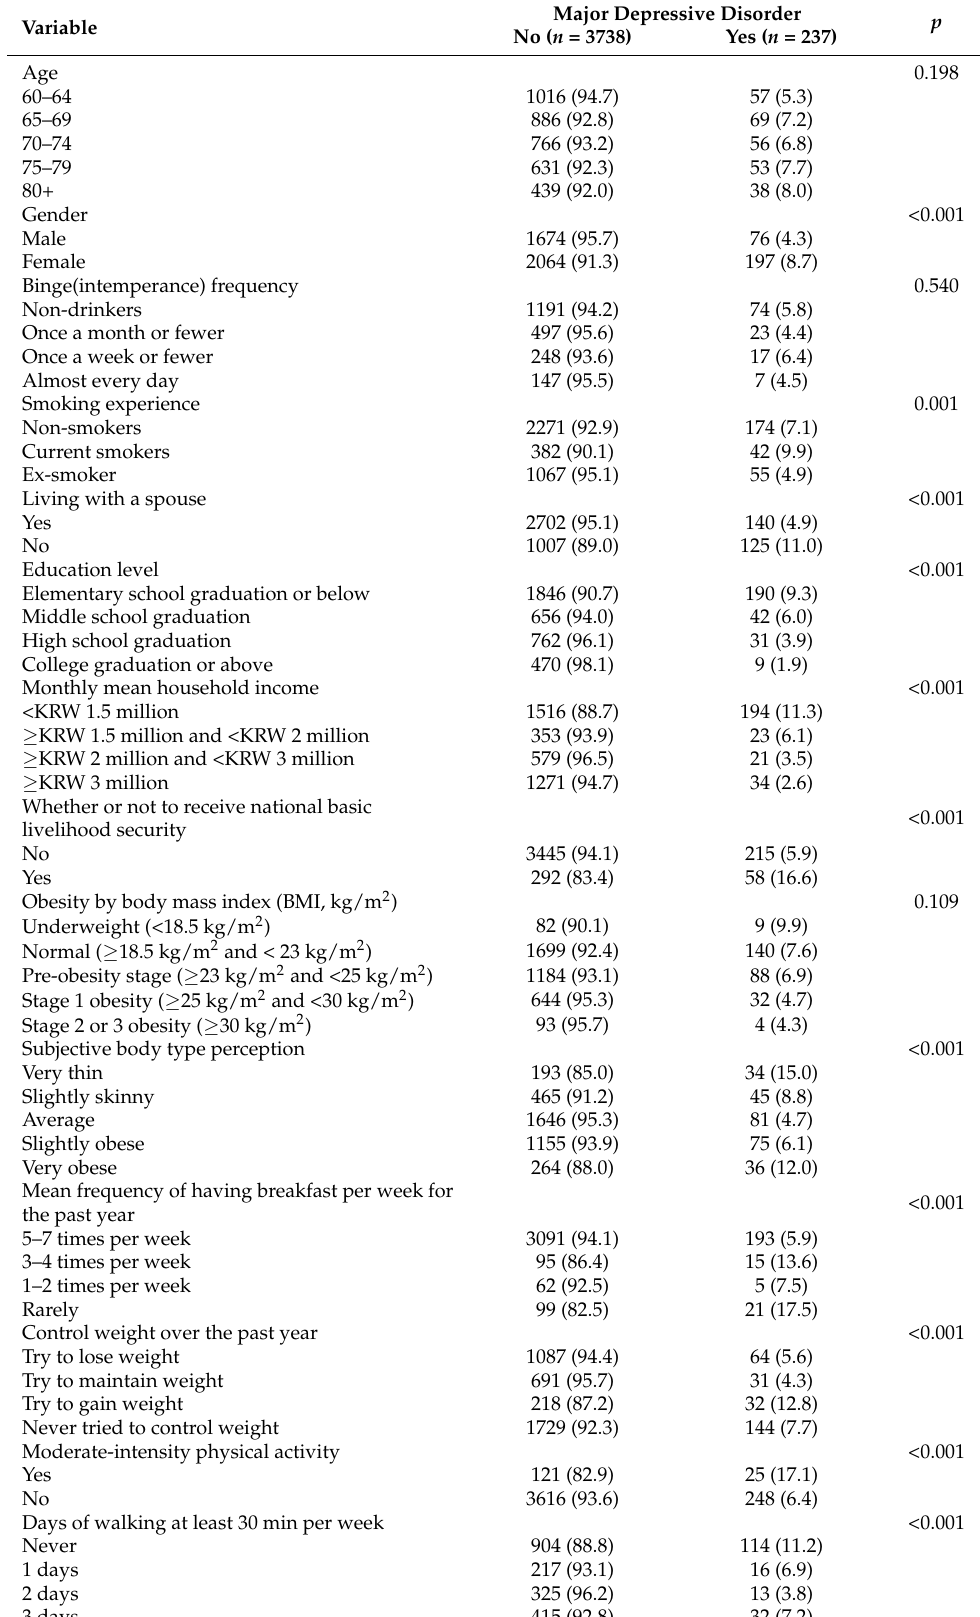
Table 2. Characteristics of subjects according to the prevalence of depression, n